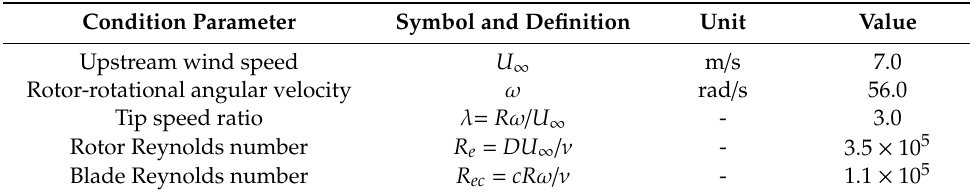
Table 2. Rotor rotational